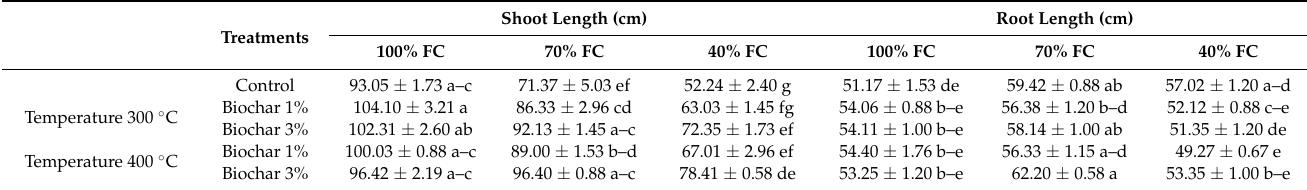
Table 2. The effect of biochar on root and shoot length of maize under drought stress.